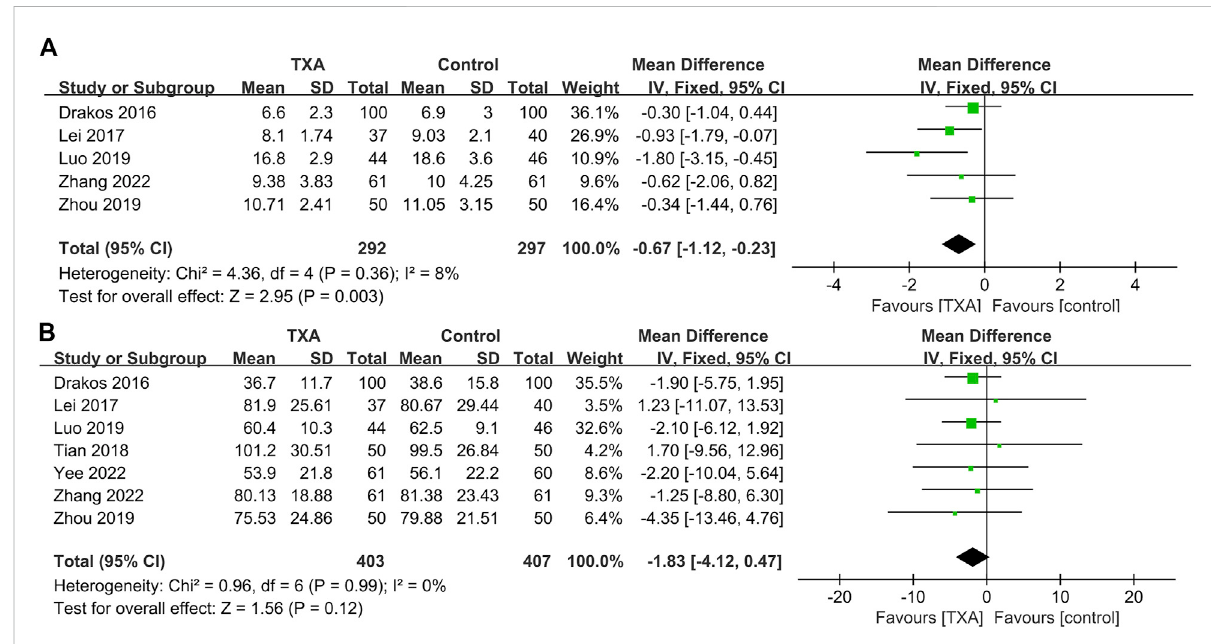
FIGURE 5 Forest plot showing non – bleeding-related outcomes of TXA group vs. control group. (A) Length of hospital stays. (B) Surgical